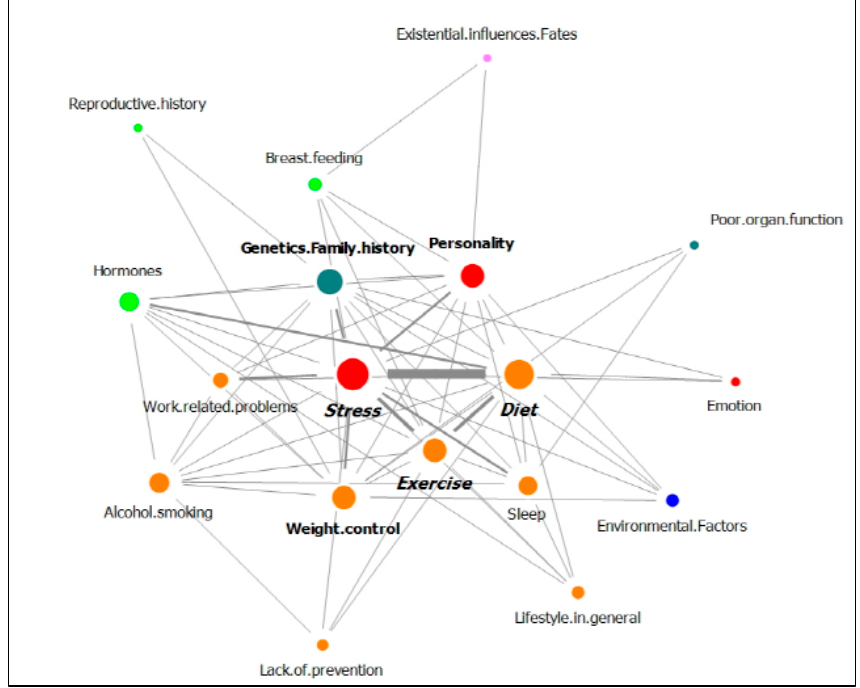
Figure 4. Network of causal attributions of breast cancer in patients with a family history of cancer (nodes of the same color mean that they belong to the same category.).